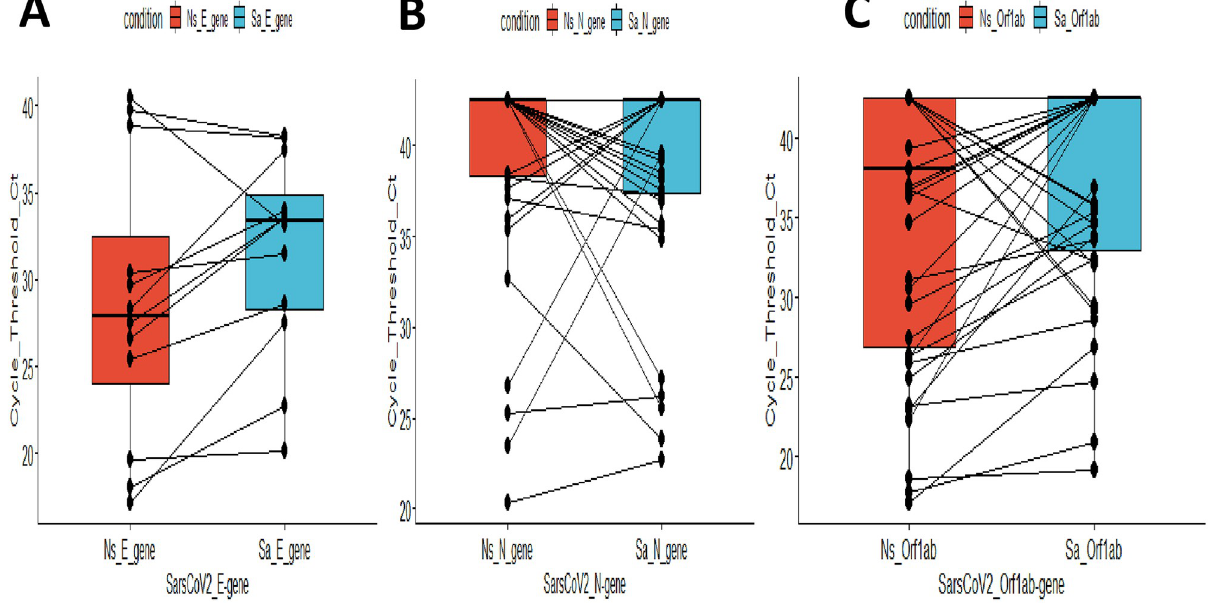
Fig 1. Cycle Threshold (Ct) values for SARS-CoV-2 positivity to (A) E-gene, (B) N-gene, and (C) Orf1ab gene respectively, show good comparison on both the Saliva and the Nasopharyngeal swab: The median Cycle Threshold (Ct) values for the three SARS-CoV-2 genes (E, N, and Orf1ab) of the positive samples (Ct < 40) and the negative samples (Ct > 40) from both the nasopharyngeal swab and saliva samples were compared using the Wilcon signed rank exact test. The p values of 0.07715, 0.8438, and 0.2293 were determined for the E, N, and Orf1 ab genes respectively. There were no statistically significant differences between the median SARS-CoV-2 E-gene, N-gene, and Orf1ab gene Ct values detected for the Nasopharyngeal swab and Saliva